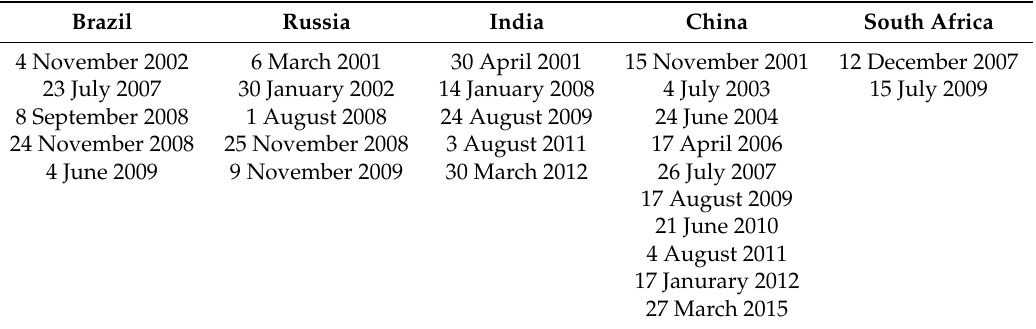
Table 2. Volatility breaks dates identified by the binary segmentation with a K 2 test.